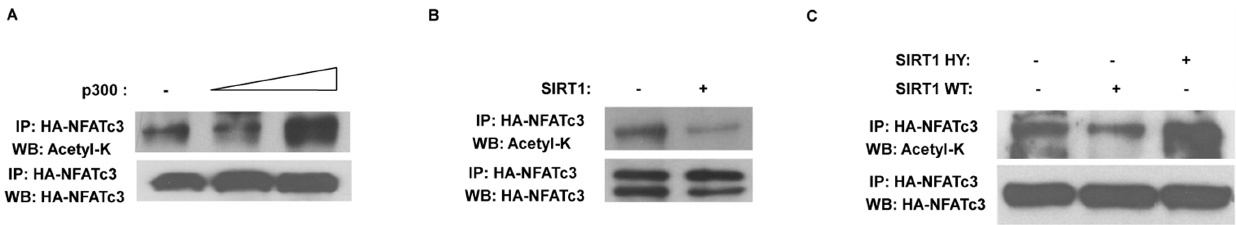
Figure 3. NFATc3 is primarily deacetylated by SIRT1. HEK293 cells were transfected with: (A) HA-tagged NFATc3 and either p300 or control (pcDNA3.1) vectors for 24 h; (B) HA-tagged NFATc3 and either SIRT1 or control (pcDNA3.1) vectors for 24 h; (C) HA-tagged NFATc3 and wild-type SIRT1 (SIRT1 WT) or dominant negative type (SIRT1H363Y) or control (pcDNA3.1) vectors for 24 h. HA-tagged NFATc3 was then immunoprecipitated and the acetylation of NFATc3 was assessed by western blotting using anti-acetylated lysine antibody. Total levels of NFATc3 were assessed with anti- HA antibody. The images are representative of three independent experiments.